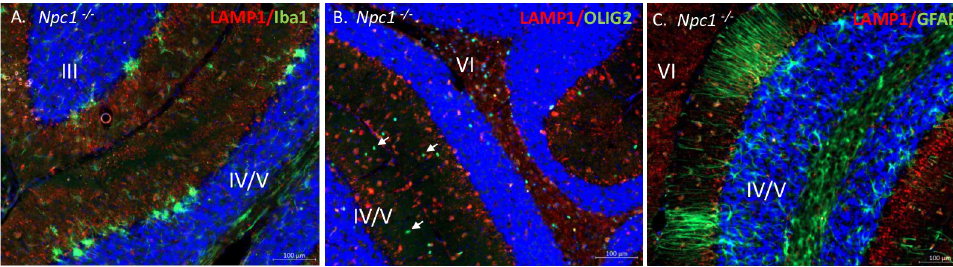
Fig 5. LAMP1 co-staining in the cerebellum. Immunohistochemistry of midline sagittal cerebellar sections of 9-week Npc1 -/- mice with LAMP1 (red) and different cerebellar cell markers (green), including: Iba1 ( A ), Olig2 ( B ), and GFAP ( C ), counterstained with DAPI (blue). Closed-arrows marks Olig2-positive oligodendrocytes (green). Cerebellar lobule numbers are